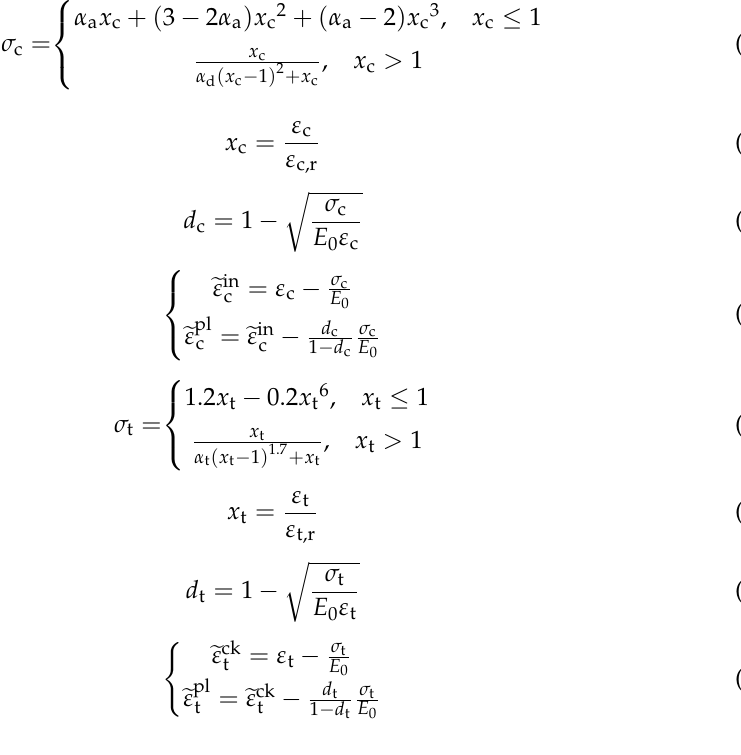
Table 1. Material parameters of C50 concrete.